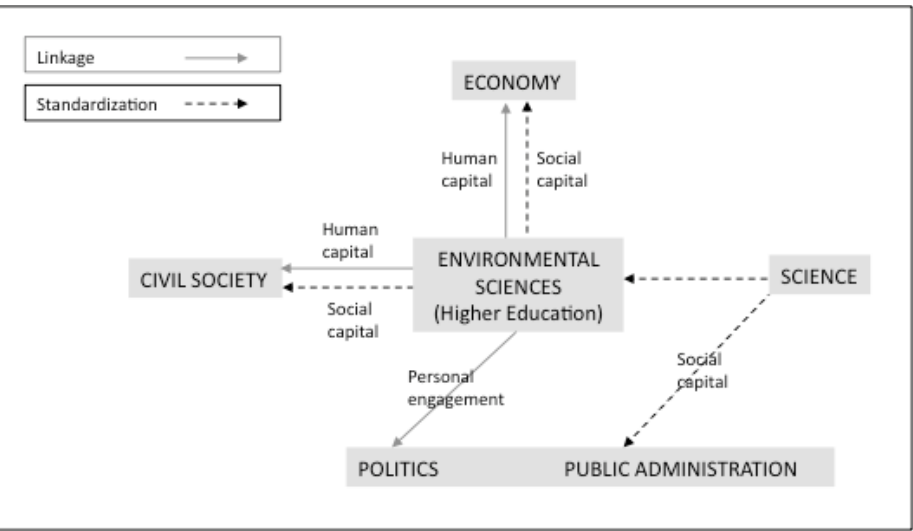
Figure 3. Standardization as a form of social capital provided by environmental sciences in Switzerland (2009 data, simplified version, cf. Brunner et al., 2010; Mieg et al., 2012). Interactions outside environmental sciences are